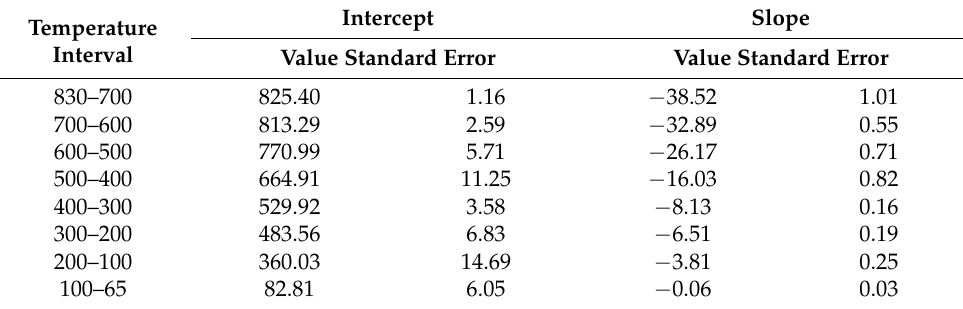
Table 5. Cooling rate of the node on the